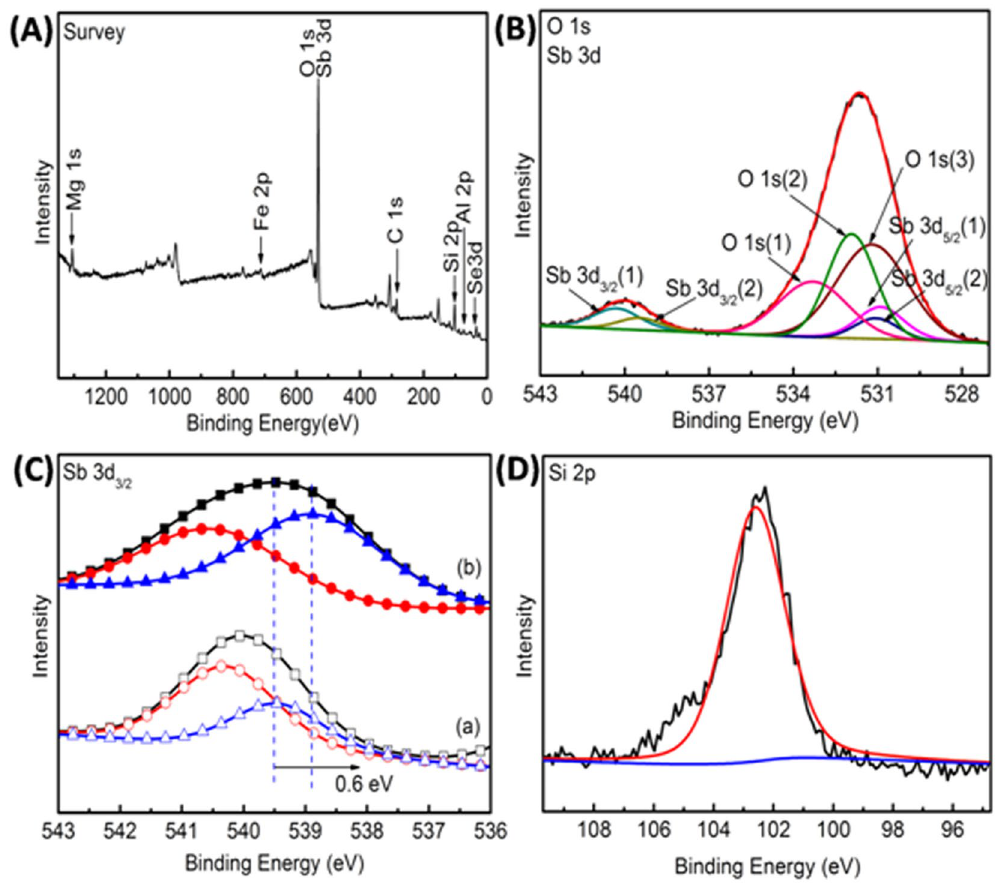
Figure 6. XPS spectra of ( A ) survey, ( B ) O 1s and Sb 3d ( D ) Si 2p region for Sb 2 Se 3 /Sb 2 O 3 @attapulgite and XPS patterns of ( C ) Sb